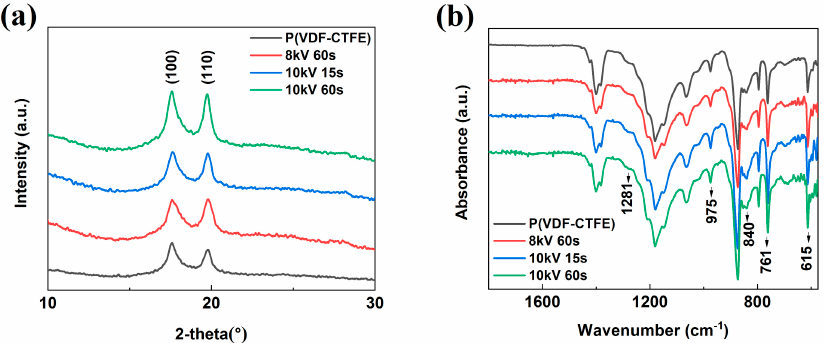
Figure 2. ( a ) XRD patterns of P(VDF ‐ CTFE) and films modified by DBD under different conditions. ( b ) ATR ‐ FTIR spectra of P(VDF ‐ CTFE) and films modified under different conditions.